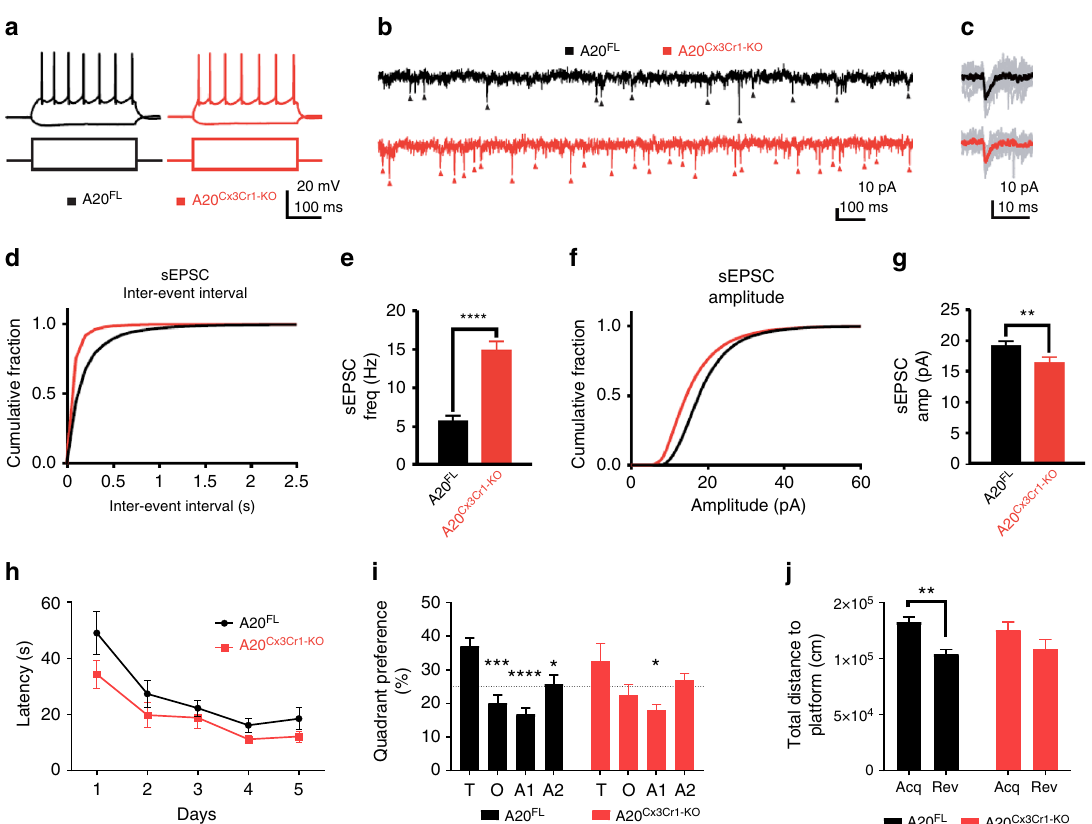
Fig. 2 Effect of microglia hyperactivation on basal network activity in somatosensory pyramidal neurons. a Example action potential (AP) fi ring pro fi les, showing the typical regular spiking behavior of layer V S1 pyramidal neurons both in control and in A20 Cx3Cr1-KO neurons. Responses to hyperpolarizing ( − 150 pA) and suprathreshold (400 pA) current injections are shown. b Example sEPSC traces, 2s stretches. c Examples of individual sEPSC events. Individual events shown in gray, averaged event shown as overlay (control, black; A20 Cx3Cr1-KO , red). d Cumulative probability distributions of inter-event sEPSC intervals (IEIs) for control (black) or A20 Cx3Cr1-KO (red) cells. e sEPSC frequency (control (black) 5.76 ± 0.58 Hz, n / m = 21/3; A20 Cx3Cr1-KO (red) 14.8 ± 1.29 Hz, n / m = 20/3; **** p < 0.0001). Data represents means ± SEM. Number of cells ( n ), number of animals ( m ). Statistical differences were determined by a two-tailed Wilcoxon matched-paired t -test. f Cumulative probability distributions for sEPSC amplitudes in control (black) or A20 Cx3Cr1-KO (red) cells. g sEPSC amplitudes (control 19.3 ± 0.69 pA, n / m = 21/3; A20 Cx3Cr1-KO 16.5 ± 0.87 pA, n / m = 20/3; ** p = 0.0013). Data represents means ± SEM. Number cells ( n ), number of animals ( m ). Statistical differences were determined by a two-tailed unpaired Mann – Whitney t -test. h Cognitive fl exibility in Morris water maze reversal learning was similar in control (A20 FL , n = 12) and A20 Cx3Cr1-KO mice ( n = 9). i In the reversal probe trial, controls displayed signi fi cant target quadrant preference, while A20 Cx3Cr1-KO mice did not (T: target quadrant, O: opposite quadrant, A1: adjacent 1 quadrant, A2: adjacent 2 quadrant). Chance level at 25% is indicated. j During the reversal probe trial, control animals searched closer to the correct reversal location for the platform than to the old location (distance to platform), while A20 Cx3Cr1-KO mice searched at equidistance to both locations. All data ( h – j ) are represented as means ± SEM and statistical differences were determined by repeated measures two-way ANOVA ( h , i ) and two-way ANOVA ( j ) using Bonferroni correction for post hoc analysis ( h – j ) (* p < 0.05, ** p < 0.01, *** p < 0.001, **** p < 0.0001) Table 1 Intrinsic properties of pyramidal neurons from control (A20 FL ) and A20 Cx3Cr1-KO mice (NS, not signi fi